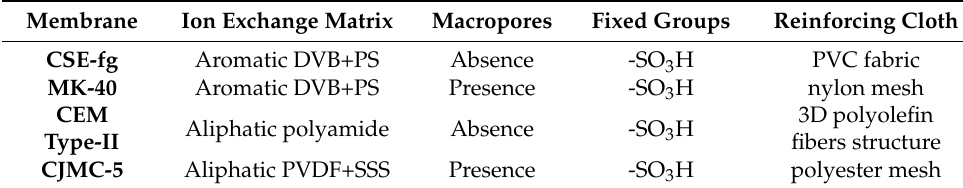
Table 2. Characteristics of membranes under